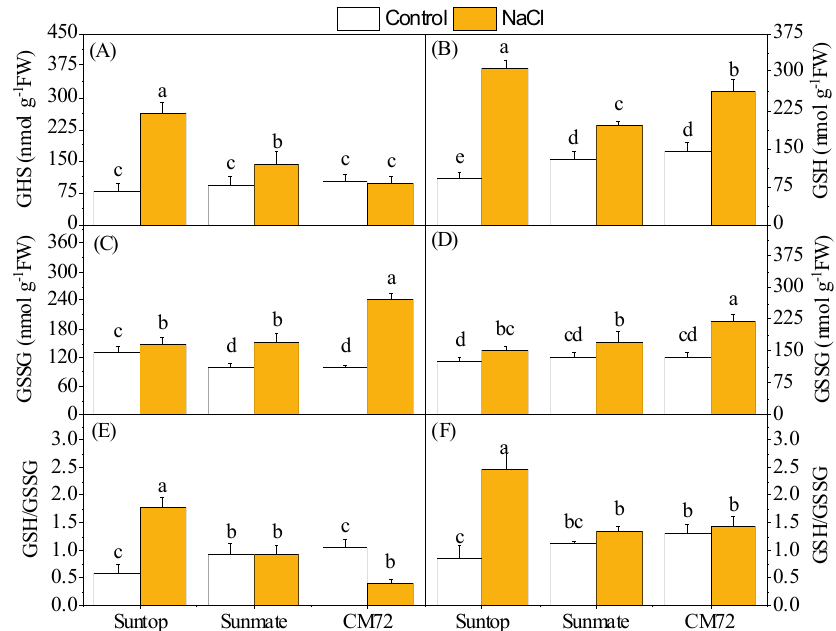
Figure 5. Contents of glutathione (GSH) ( A, B ) and oxidized glutathione (GSSG) ( C, D ), and the ratio of GSH/GSSG ( E, F ) in leaves (left panel) and roots (right penal) of two wheat cultivars—Suntop and Sunmate—and barley cultivar CM72 exposed for 7 days to 100 mM of NaCl. Different letters indicate a significant difference ( p ≤ 0.05) between NaCl treatment and control within the two wheat cultivars and barley cv. CM72.